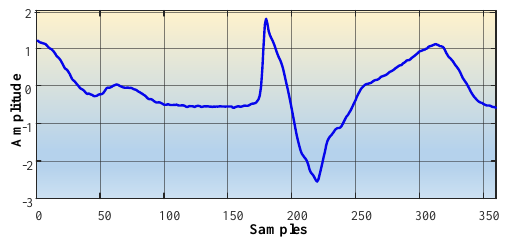
Figure 4. Paced arrhythmia signal example.